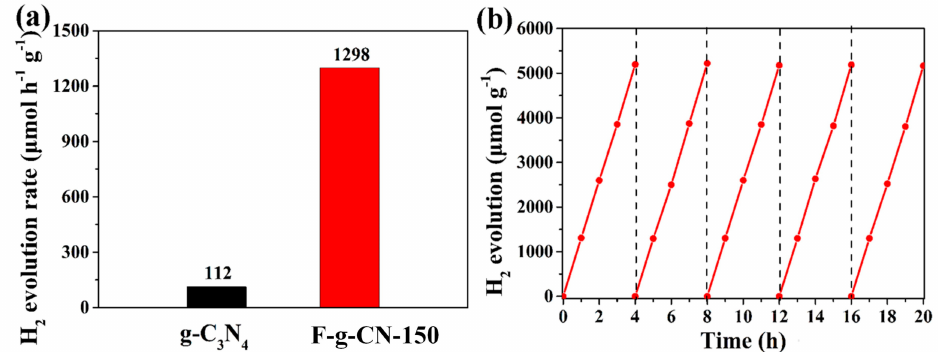
Figure 8. ( a ) Photocatalytic H 2 evolution rates for g-C 3 N 4 and F-g-CN. ( b ) Cycling tests of H 2 evolution with F-g-CN-150.